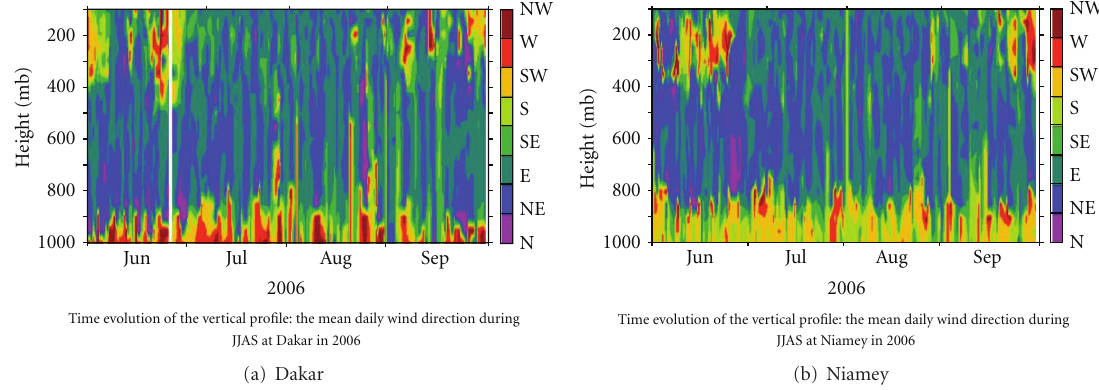
Figure 8: Daily wind direction profiles in Dakar and Niamey at 0000 UTC and 1200 UTC of JJAS